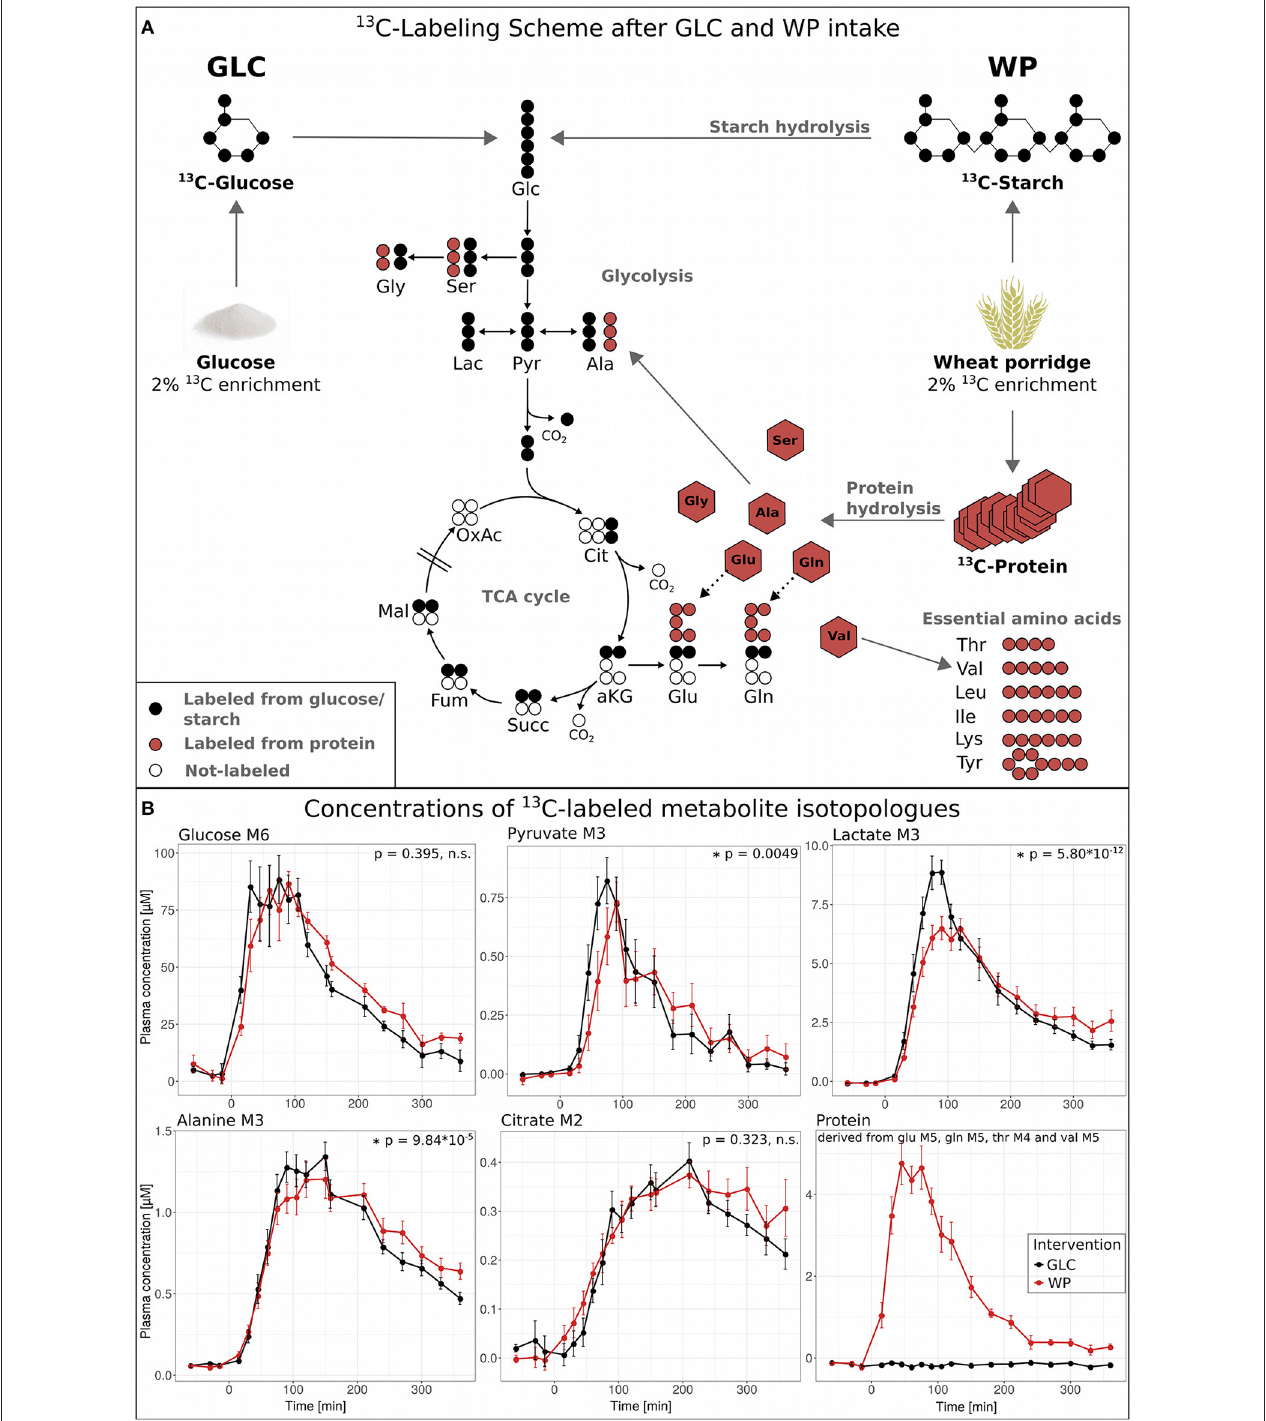
FIGURE 2 | 13 C metabolic flux analysis in the postprandial phase. (A) Overview of 13 C tracer metabolism for both interventions: GLC (2% 13 C-enriched glucose solution, black) and WP (wheat porridge with 2% 13 C-labeled wheat flour, red). (B) Concentrations of 13 C-labeled metabolite isotopologues glucose M6, pyruvate M3, lactate M3, alanine M3, and citrate M2 and protein (derived from glutamate M5, glutamine M5, valine M5 and threonine M4), displayed is the average of 11 study subjects ± standard error of the mean (SEM), statistics: repeated measures (rm) ANOVA. Glc, glucose; Ser, serine; Gly, glycine; Pyr, pyruvate; Lac, lactate; Ala, alanine; Cit, citrate; aKG, α -ketoglutarate; Succ, succinate; Fum, fumarate; Mal, malate; OxAc, oxaloacetate; Glu, glutamate; Gln, glutamine; Thr, threonine; Val, valine; Leu, leucine; Ile, isoleucine; Lys, lysine; Tyr, tyrosine.